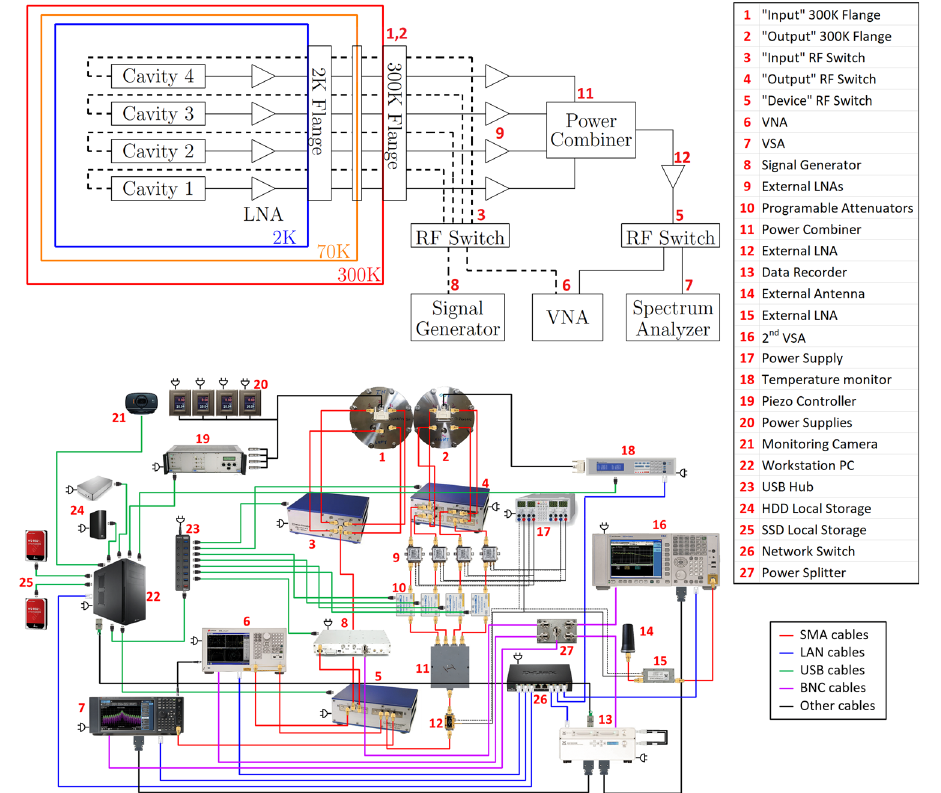
Fig. 2 | Top: Simpli fi ed outline of the CAST-CAPP setup. The dashed and solid lines correspond to connections in each cavity input and output port respectively. Thecavitiesareactuallyalignedalongtheaxisoftheirlengthasoneaftertheother.